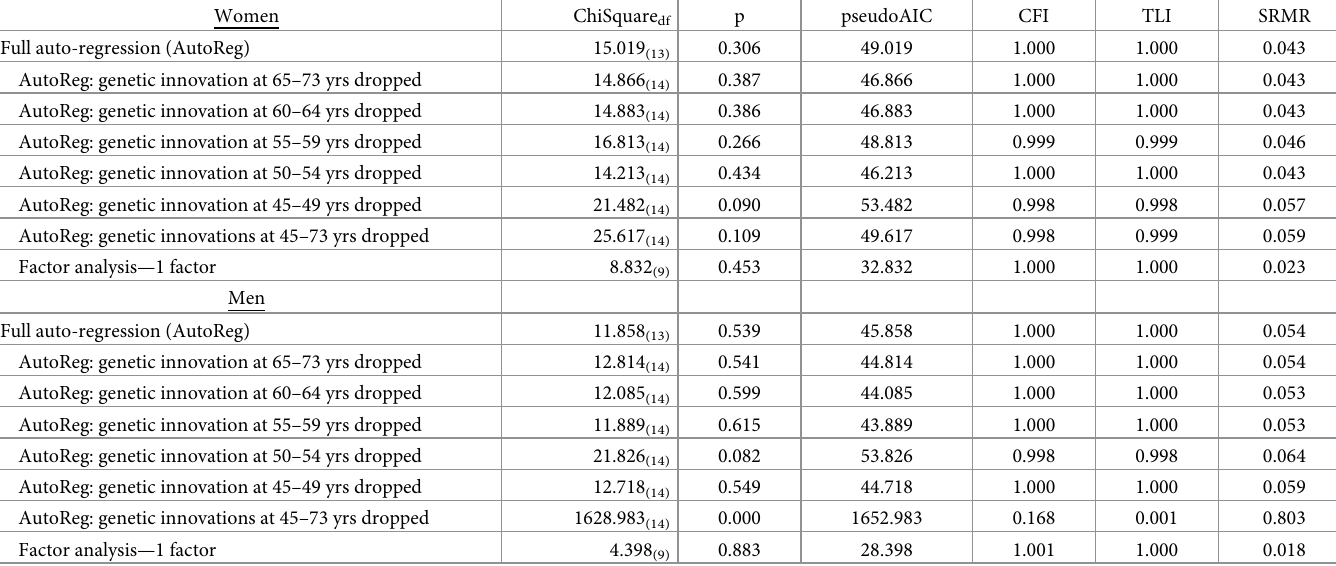
Table 4. Multivariate modeling fitting comparisons based on the combined MALE GWAS summary statistics at six age